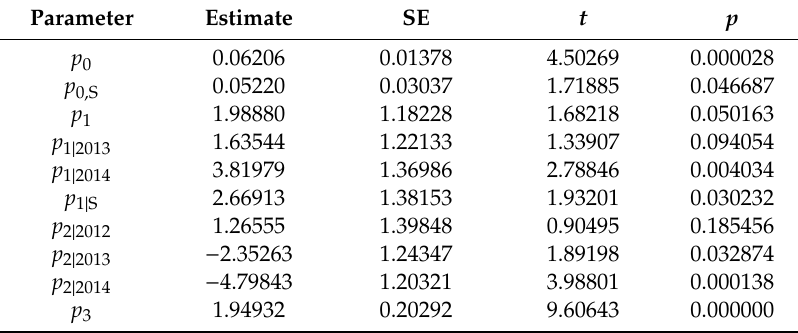
Table 1. Parameter estimates of Equation (1) relating survival from L 4 to adult. Full model. R 2 =